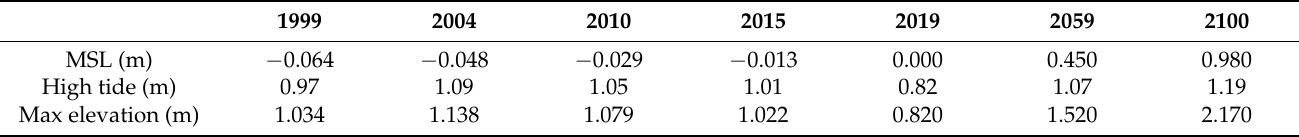
Table 5. Maximum elevation in front of the coast for the predicted SLR scenarios.